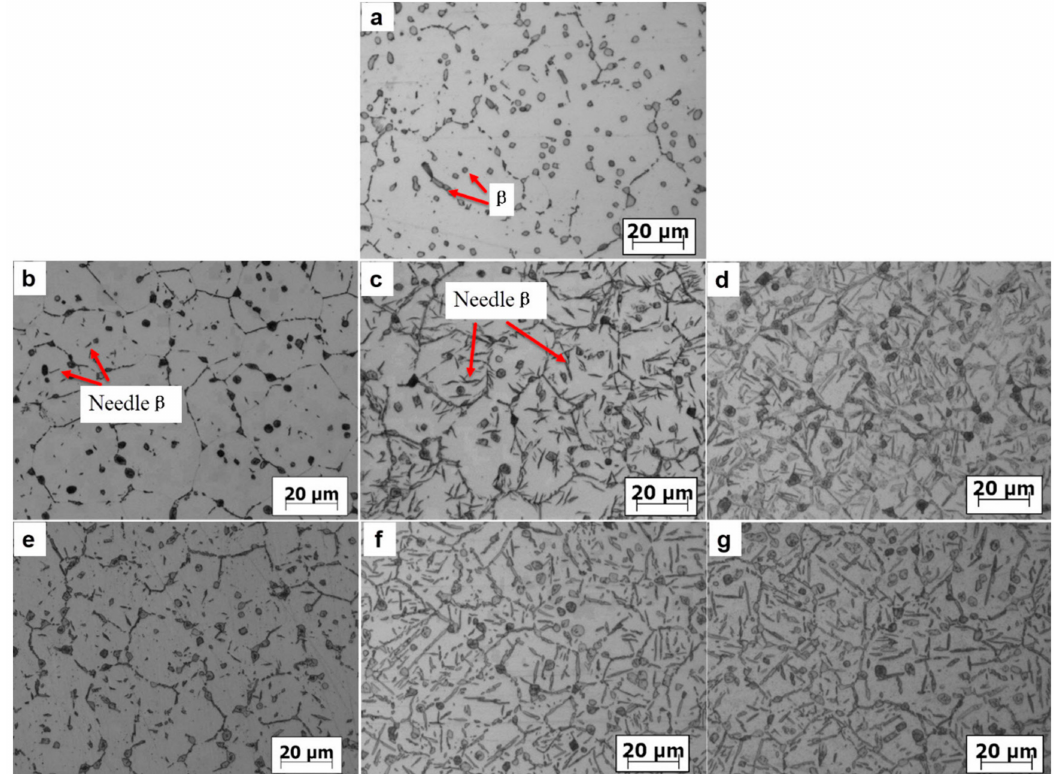
Figure 3. Optical microscope (OM) micrographs of Inconel 783 alloy bolts with di ff erent aging temperatures and times: ( a ) 0 h, ( b ) 650 ◦ C—1000 h, ( c ) 650 ◦ C—3000 h, ( d ) 650 ◦ C—20,000